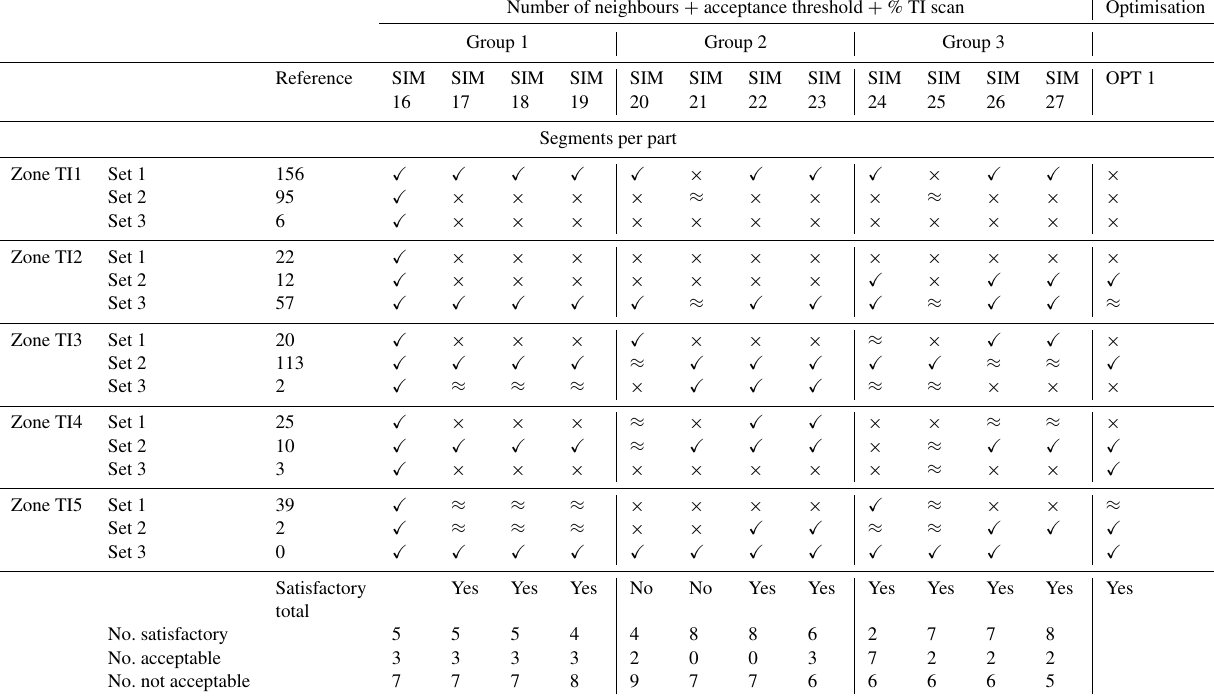
Table 6. Results of the sensitivity analysis on the influence of the number of neighbours, of the variation of the acceptance threshold and of the variation of the percentage of the scanned fraction of the training image. The symbols are the same as those used in Tables 4 and